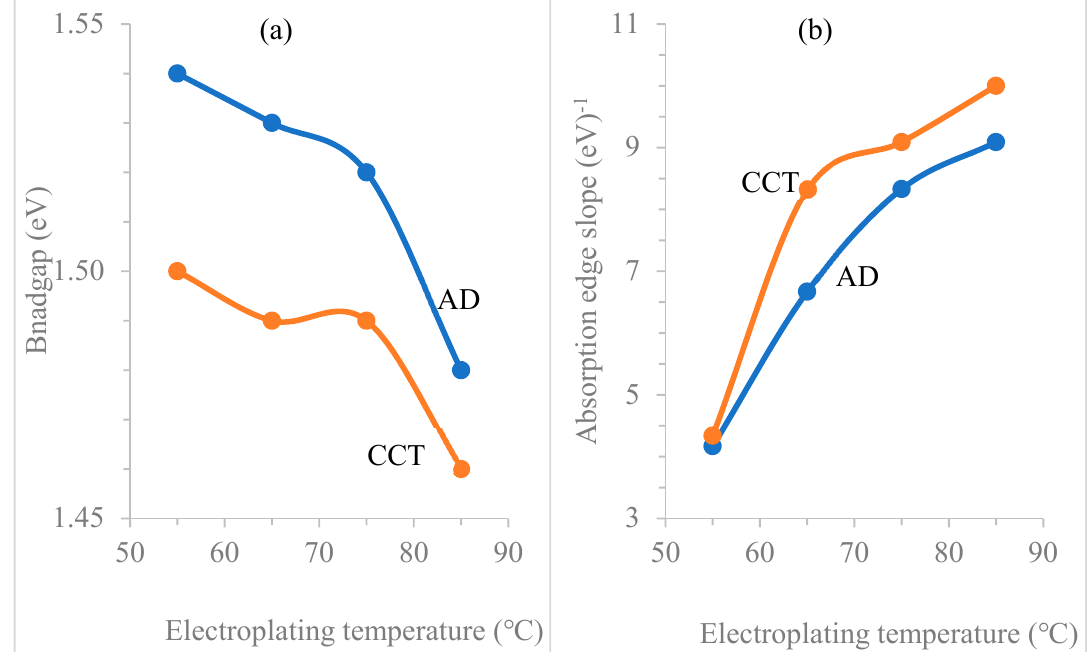
Figure 7. ( a ) A plot of optical bandgap of CdTe electroplated from electrolytes at different deposition temperature and ( b ) is the absorption edge slope of the CdTe layers under both AD and CCT conditions against deposition temperature.